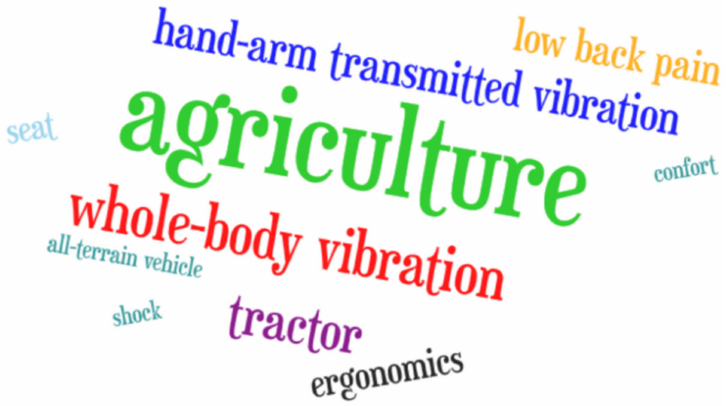
Figure 5. Keyword information clustering of the relevant